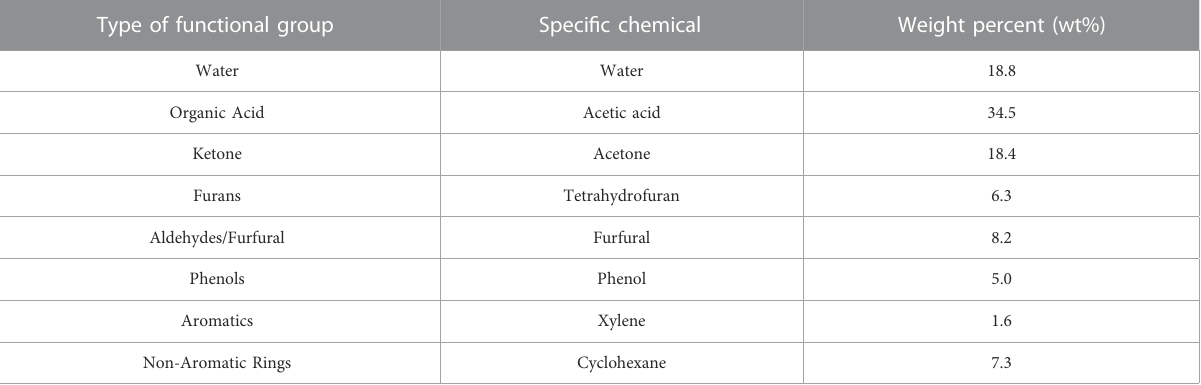
TABLE 1 Composition of synthetic bio-oil. Type of functional